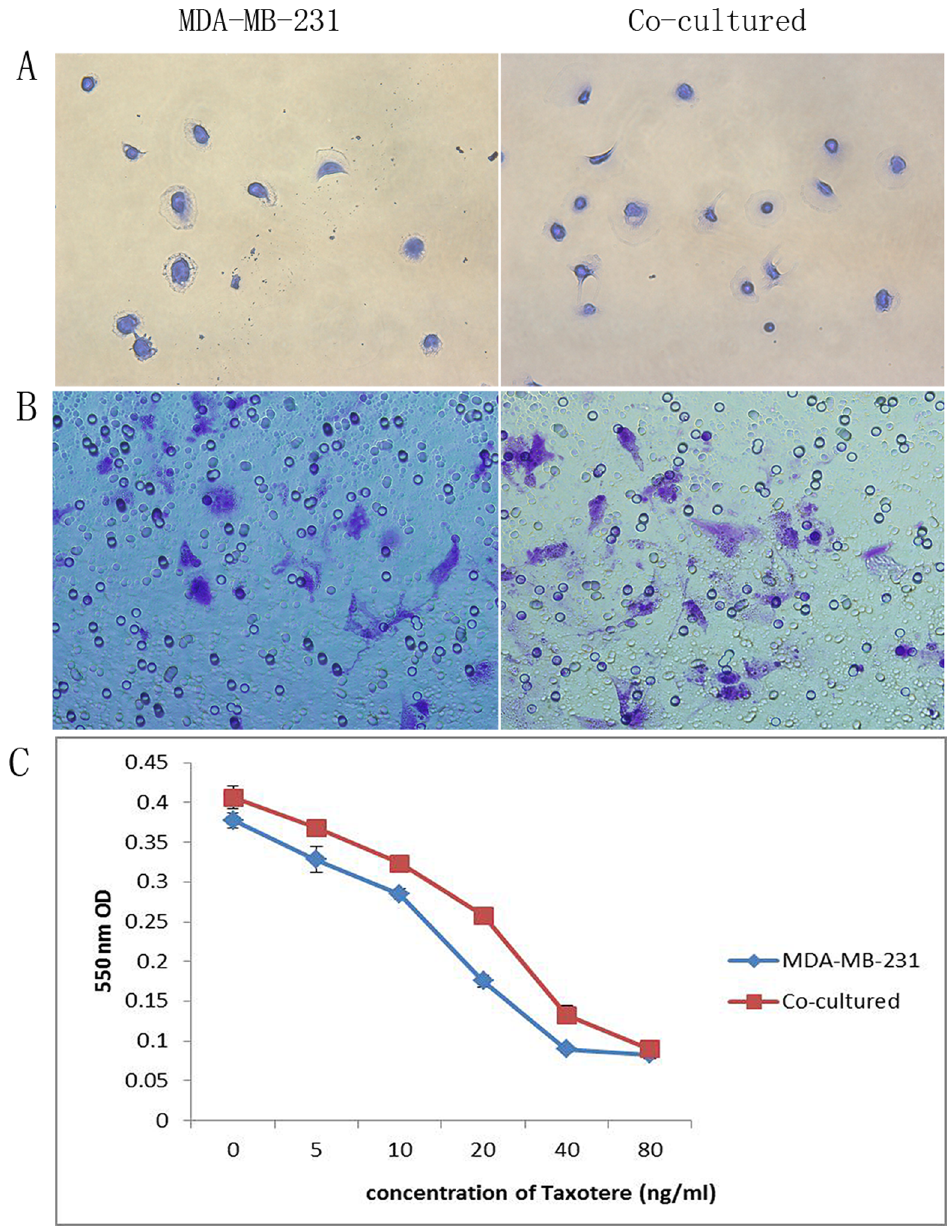
Figure 2. The function comparison of MDA-MB-231 cells co-cultured with CAFs and MDA-MB-231 cells without co-culture, when treated with Taxotere. By using cell adhesion assay (A), invasion assay (B), and MTT assay (C), it was observed that after chemotherapy, MDA-MB- 231 cells co-cultured with CAFs displayed increasing adhesion, invasiveness and proliferation abilities, compared with cells without co-culture.